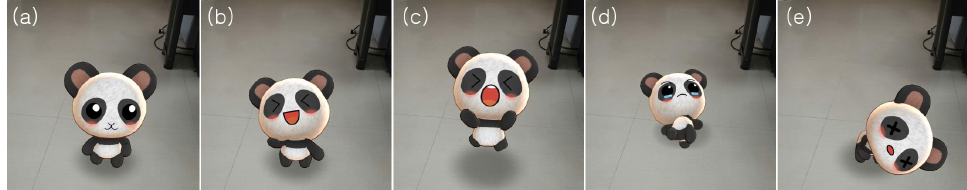
Figure 2. Snapshots of virtual pet’s behavioral animations: ( a ) idling, ( b ) greeting, ( c ) jumping, ( d ) falling over, and ( e ) begging for